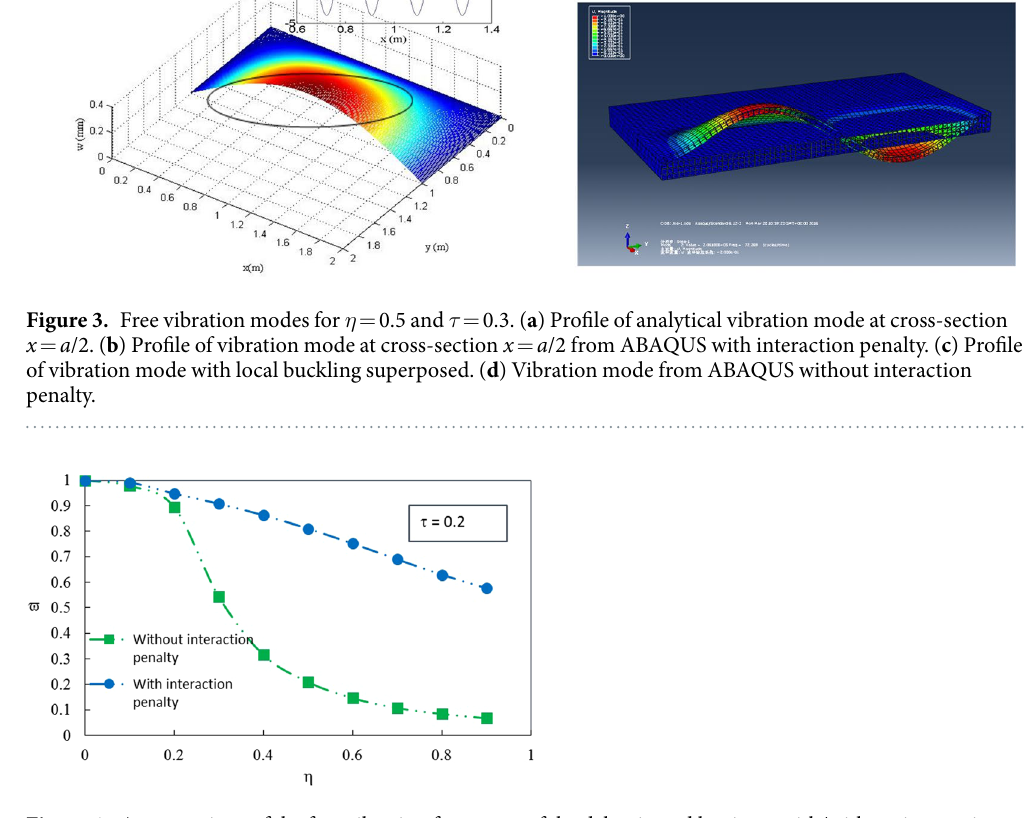
quite short wavelength. With these features, once the delaminated laminate undergoes vibration, local voids are formed on the interfaces at places where upper Sublaminate Ω (2) and lower Sublaminate Ω (3) buckles upwards and downwards respectively. Between the voids the two sublaminates buckle in the opposite directions. Interaction forces are produced in these regions. With these characteristics, voids and interaction areas are developed alter- nately at the interfaces of the delamination, as illustrated in Fig. 3c. It is remarkable that the magnitudes of the local buckles are only about 10 − 3 of the magnitudes of the vibration modes, so the voids are microscopic, invisible to the naked eyes. For a more comprehensive understanding of the situation, we further investigate cases of different length of delamination with/without the interaction penalty. Figure 4 shows a comparison of the free vibration frequency of the delaminated laminate with/without interaction penalty enforced at the interfaces of the delamination from ABAQUS analysis. The results reveal that the delaminated laminate vibrates in modes of much high frequency when the penalty conditions are enforced. The reason for such difference is that the penalty conditions link the separate sublaminates together as a unitary one, thus greatly enhance the stiffness of the delaminated laminate. We further carry out a parametric study to investigate the influence of the delamination properties on the vibration frequency. Variation of the nondimensional frequency ω with respect to the nondimensional delamina-